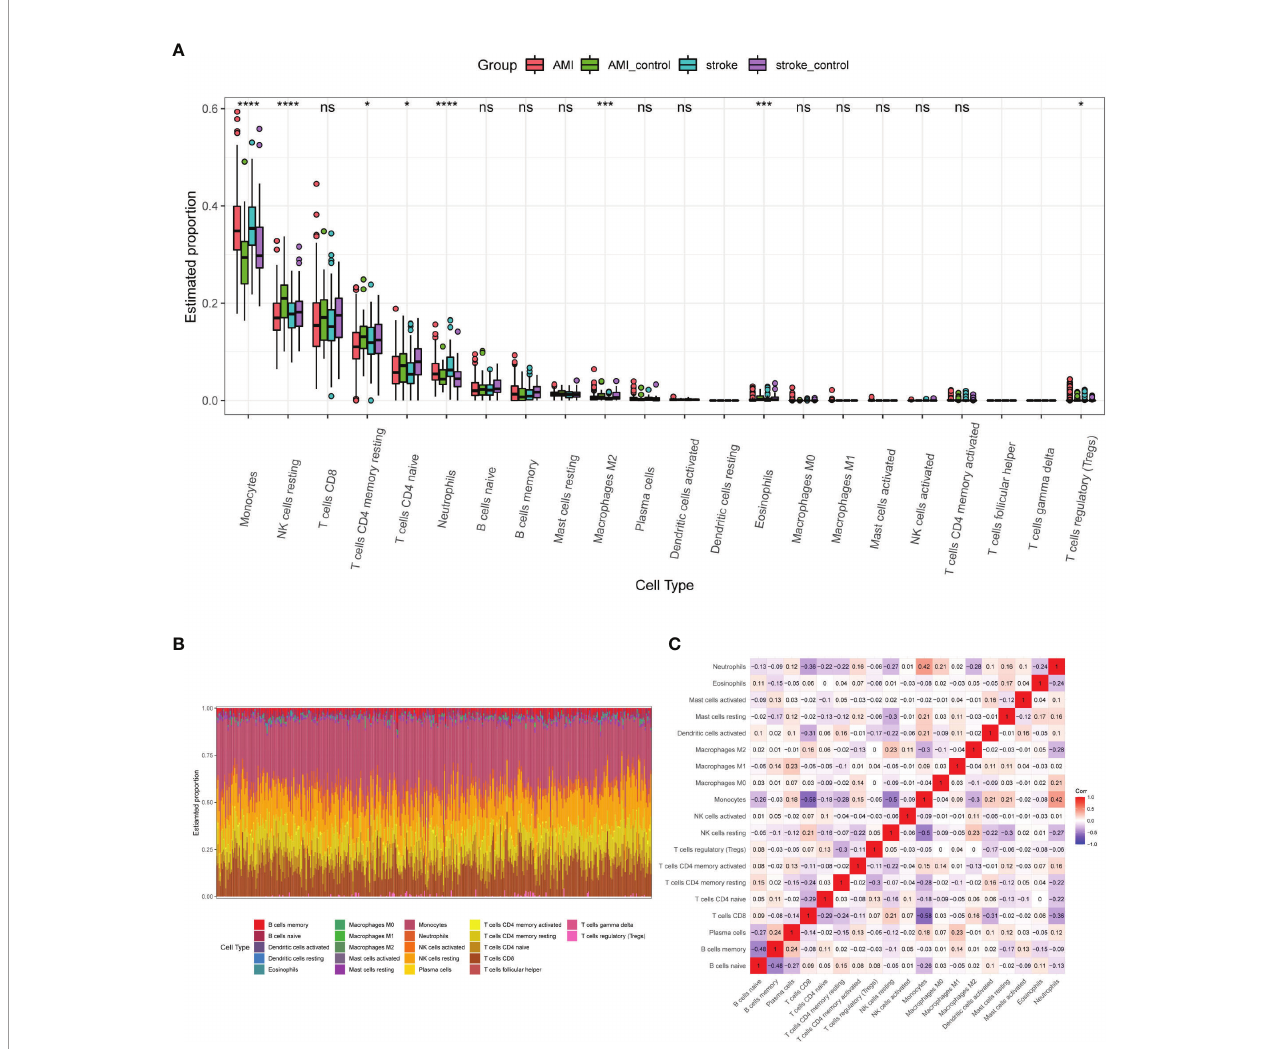
FIGURE 4 | Pro fi les of immune cell in fi ltration patterns in the basic datasets. (A) Estimated proportions of 22 immune cell types in AMI and IS. Statistical signi fi cance was determined by Kruskal test analysis. * P -value < 0.05; *** P -value < 0.001, **** P -value < 0.0001. NS, not signi fi cant. (B) Heatmap of the immune cell proportions in each sample. (C) Correlation heatmap of 19 immune cell types (three were excluded as their proportion was